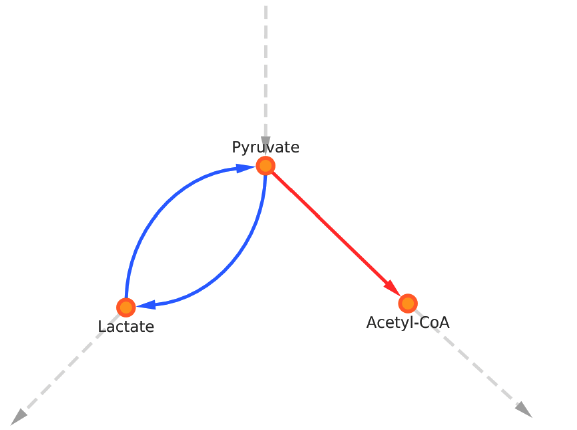
Figure 3. Metabolic branches from